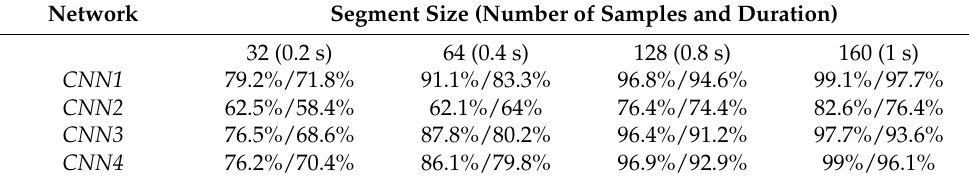
Table 7. Accuracy on PhysioNet data for 10/20 subjects.